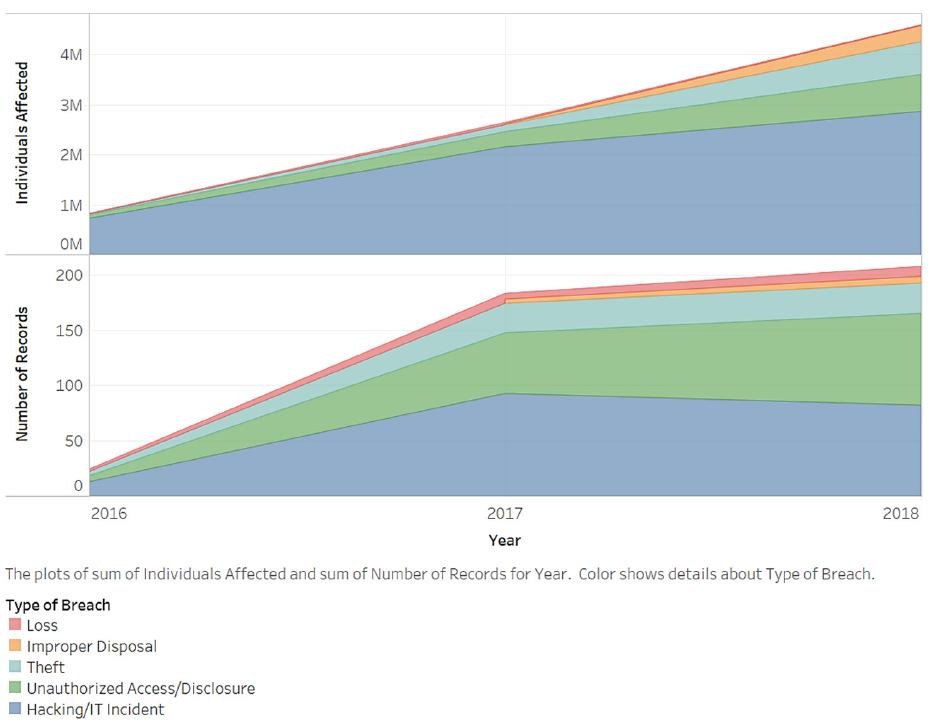
Figure 13 ranks the types of breaches, trends in time, and accumulated values. The ranking of types remained the same for both the number of records and affected individuals.